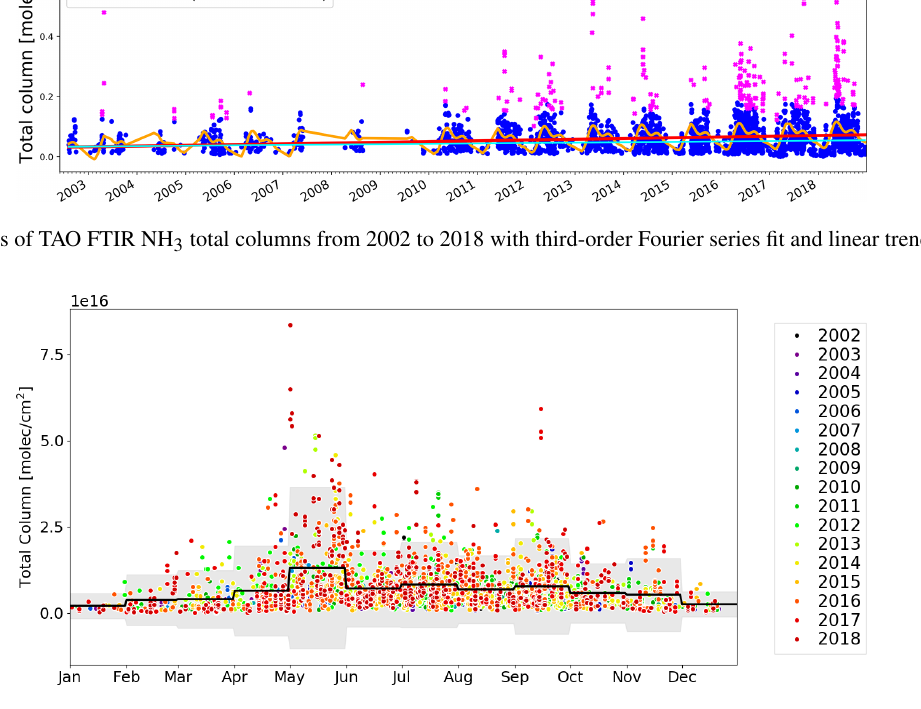
Figure 2. TAO FTIR NH 3 total columns plotted from January to December for 2002 to 2018. Monthly averages and ± 2 σ are indicated by the black line and shading, respectively.